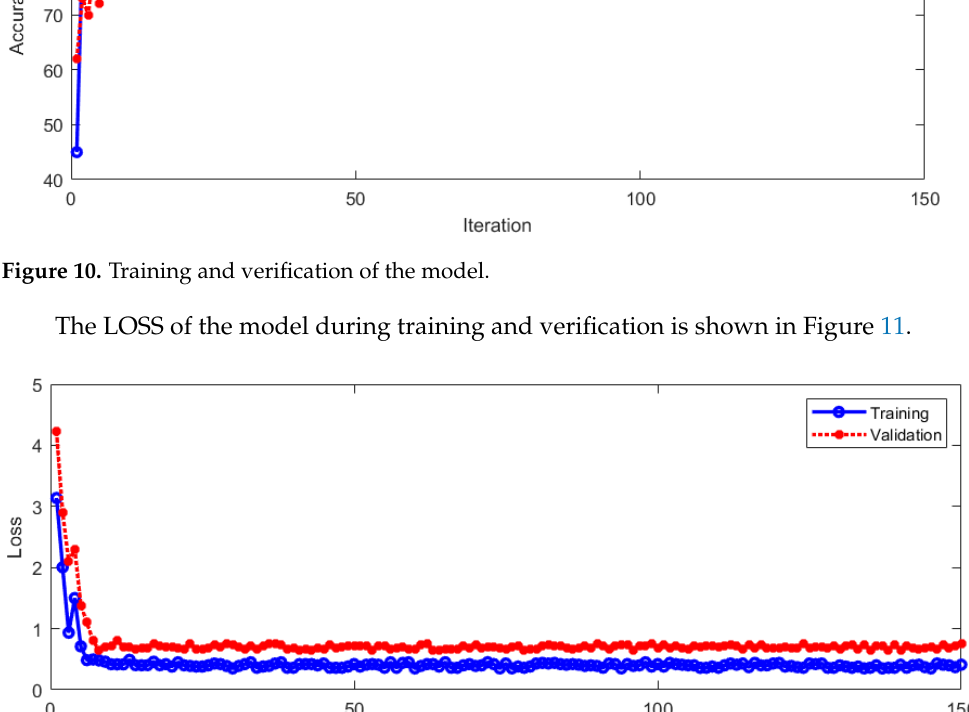
Figure 11. LOSS during training and verification.